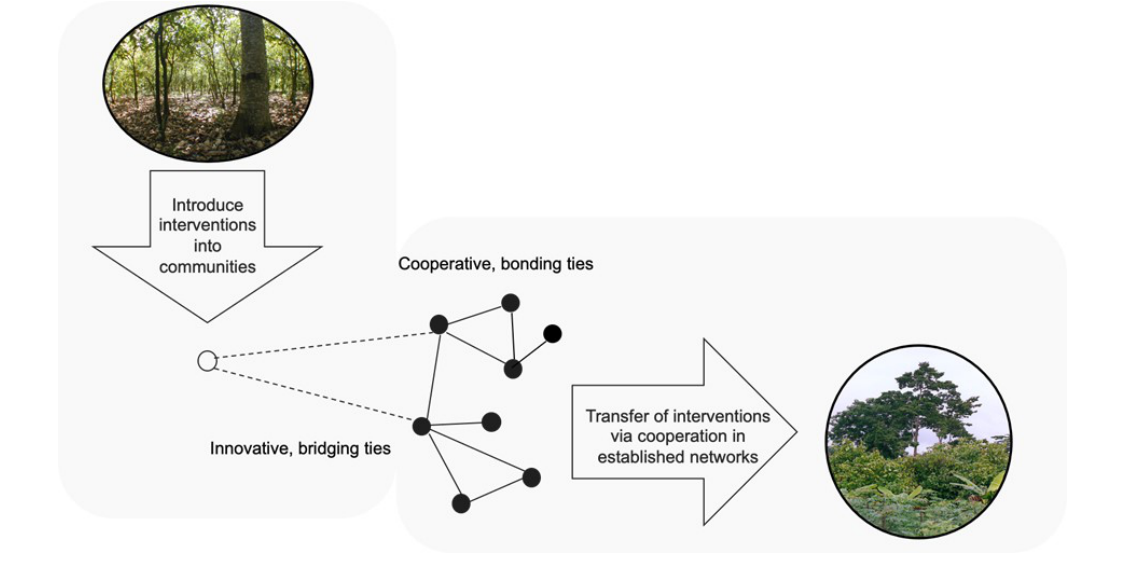
Fig. 1 . Networks are often used in the adoption of agrobiodiversity. Bridging ties between institutions and farmers introduce an intervention, which flows via bonding ties within established networks via farmer to farmer learning. Solid lines indicate cooperative farmer to farmer ties and dashed lines indicate innovative farmer to institutions ties. Filled circles are individual farmers and the empty circle represents an external